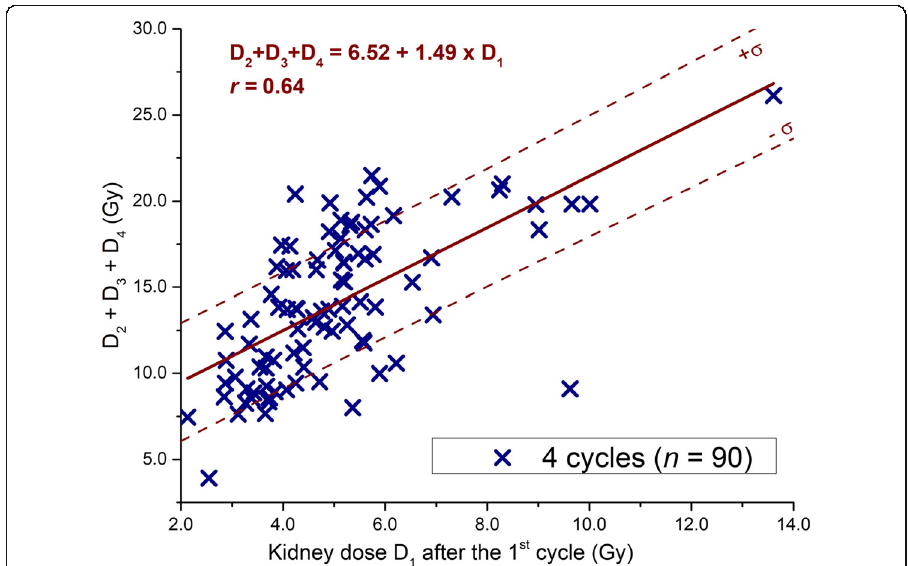
Fig. 3 Relationship between D 1 and D 2 + D 3 + D 4. Legend: Relationship between the sum of the doses D 2 + D 3 + D D 4 and the dose after the first cycle 1 . The standard deviations of the fitted data are shown in dotted